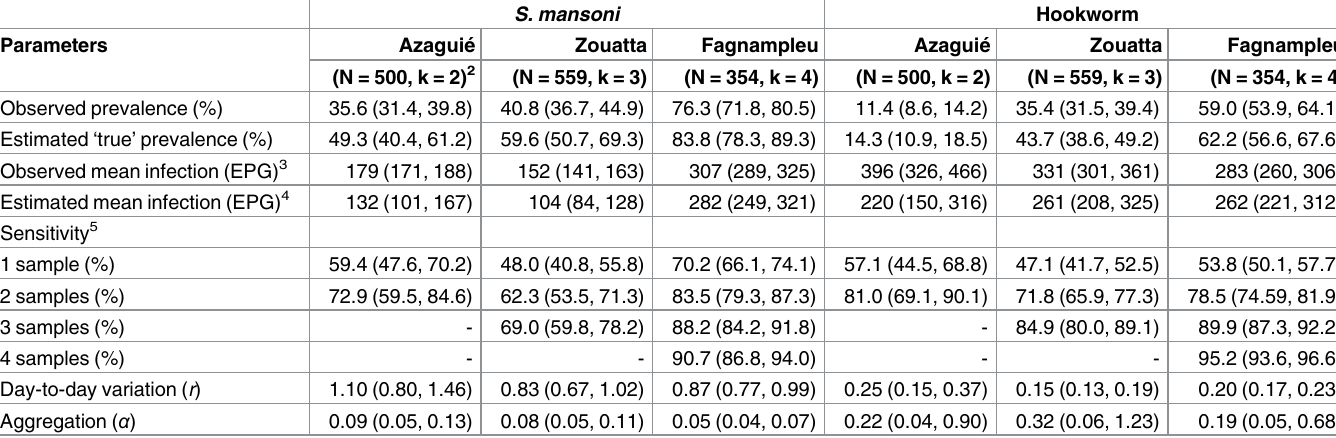
Table 1. Resulting parameters of the simulations (mean and 95% BCI 1 ) parametersof the mean infection and of the prevalenceof S. mansoni and hookworm in Azaguie´, Zouatta, and Fagnampleu in Coˆte d’Ivoire. Observed prevalenceis the ratio of positivelytested individualsin the originalstudy, observedmean infectionthe arithmetic mean egg count of the individualswith a positive